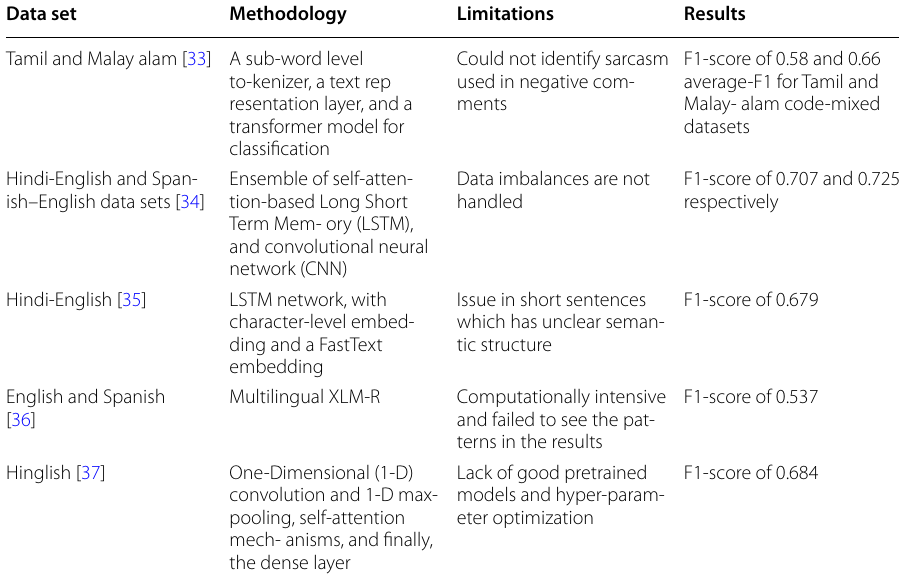
Table 1 Recent references in a nutshell Data set